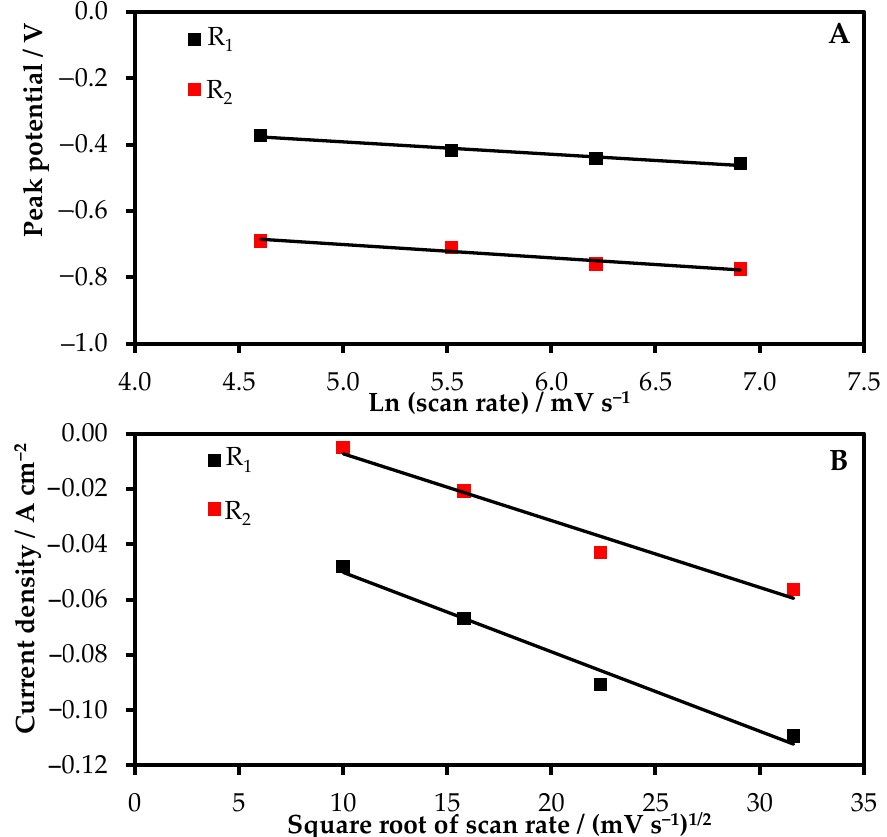
Figure 5. The dependences of the cathodic peak potential on the logarithm of the scan rate ( A ); the relationship between the current density and the square root of scan rate ( B ).